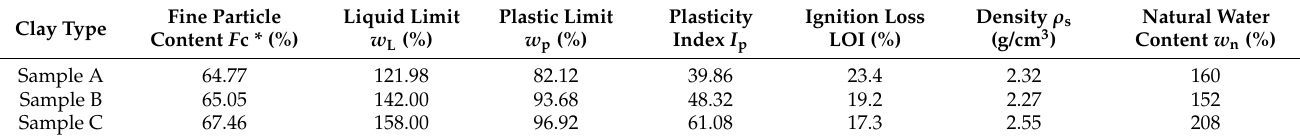
Table 1. Physical properties of Kumamoto